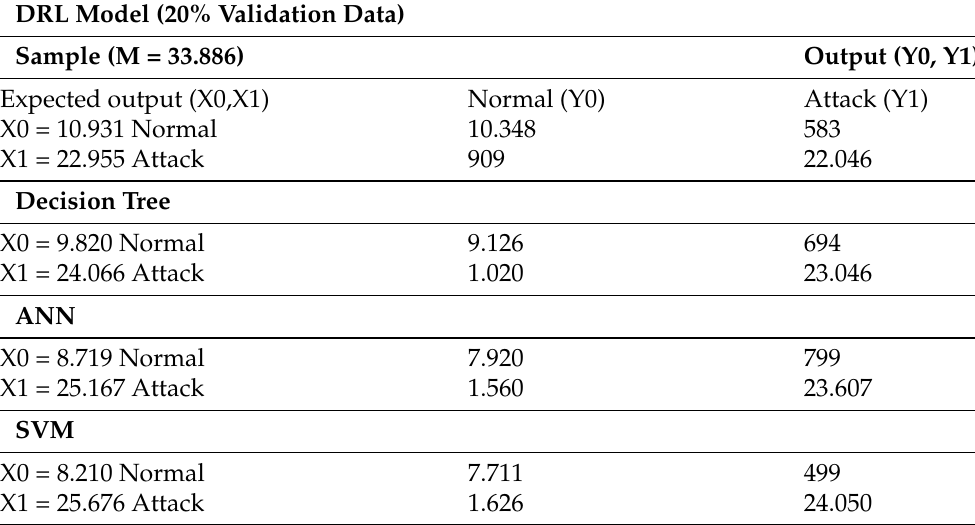
Table 5. Blockchain-based smart home using DRL training set records during validation.